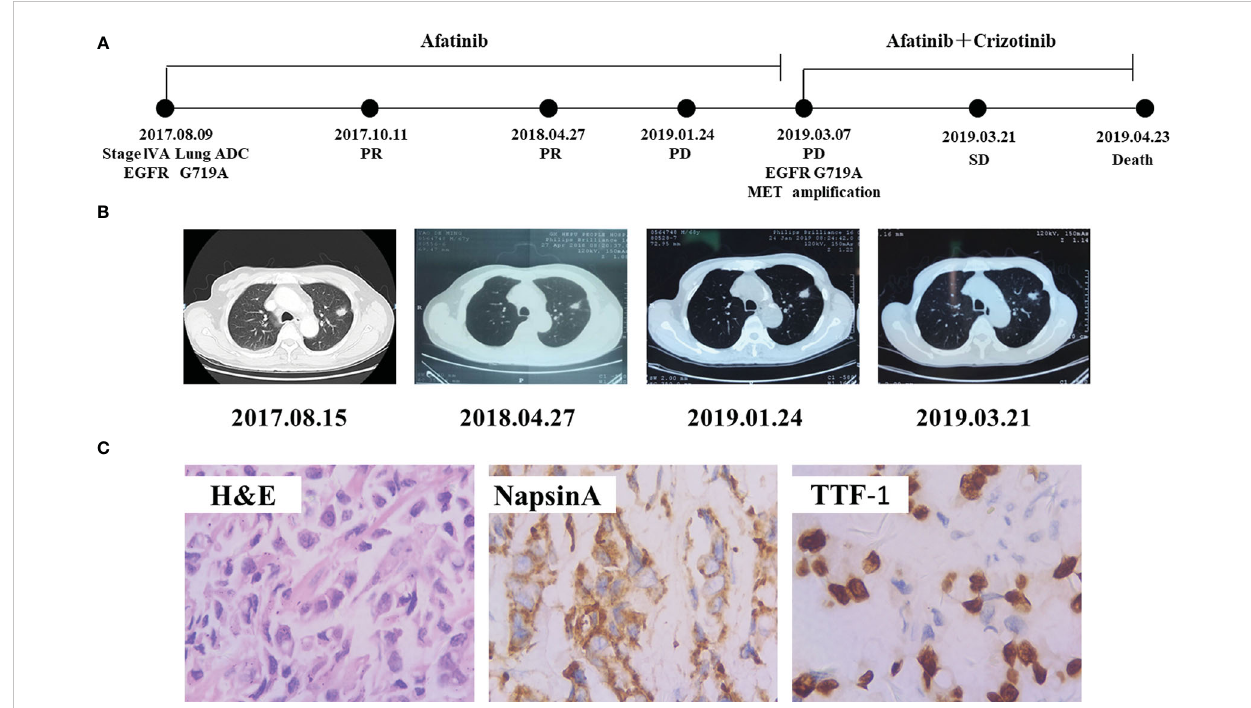
FIGURE 3 Schematic of treatment history of Case 3. (A) The timeline of treatment. (B) Chest CT images throughout the disease course. (C) Pathological examination of the surgical specimen. IHC testing (400×) results showed positive expression of Napsin A and